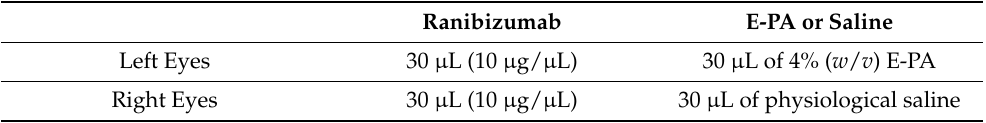
Table 1. Dosing regimen of rabbits to each eye for in vivo study.